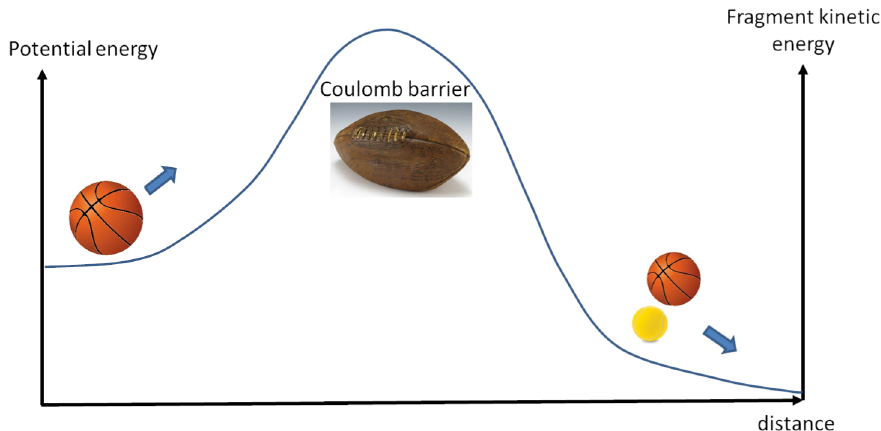
Fig. 2. – Nuclear potential energy as a function of the distance between the two